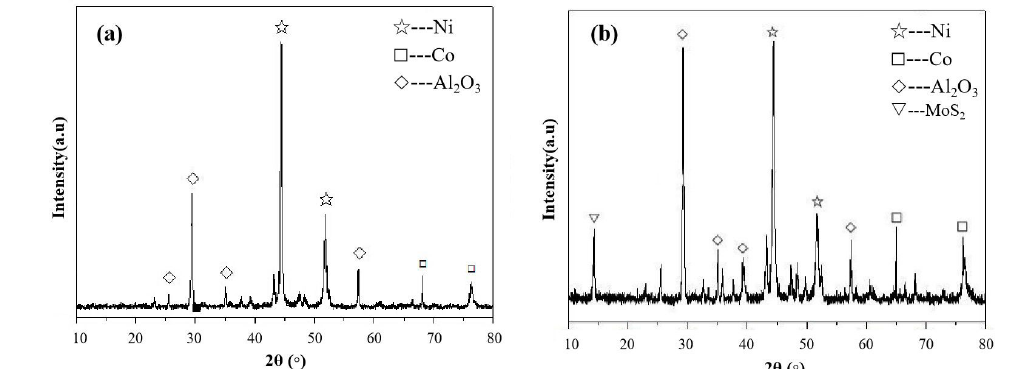
, (b) adding 1.0 g·L -1 MoS 2